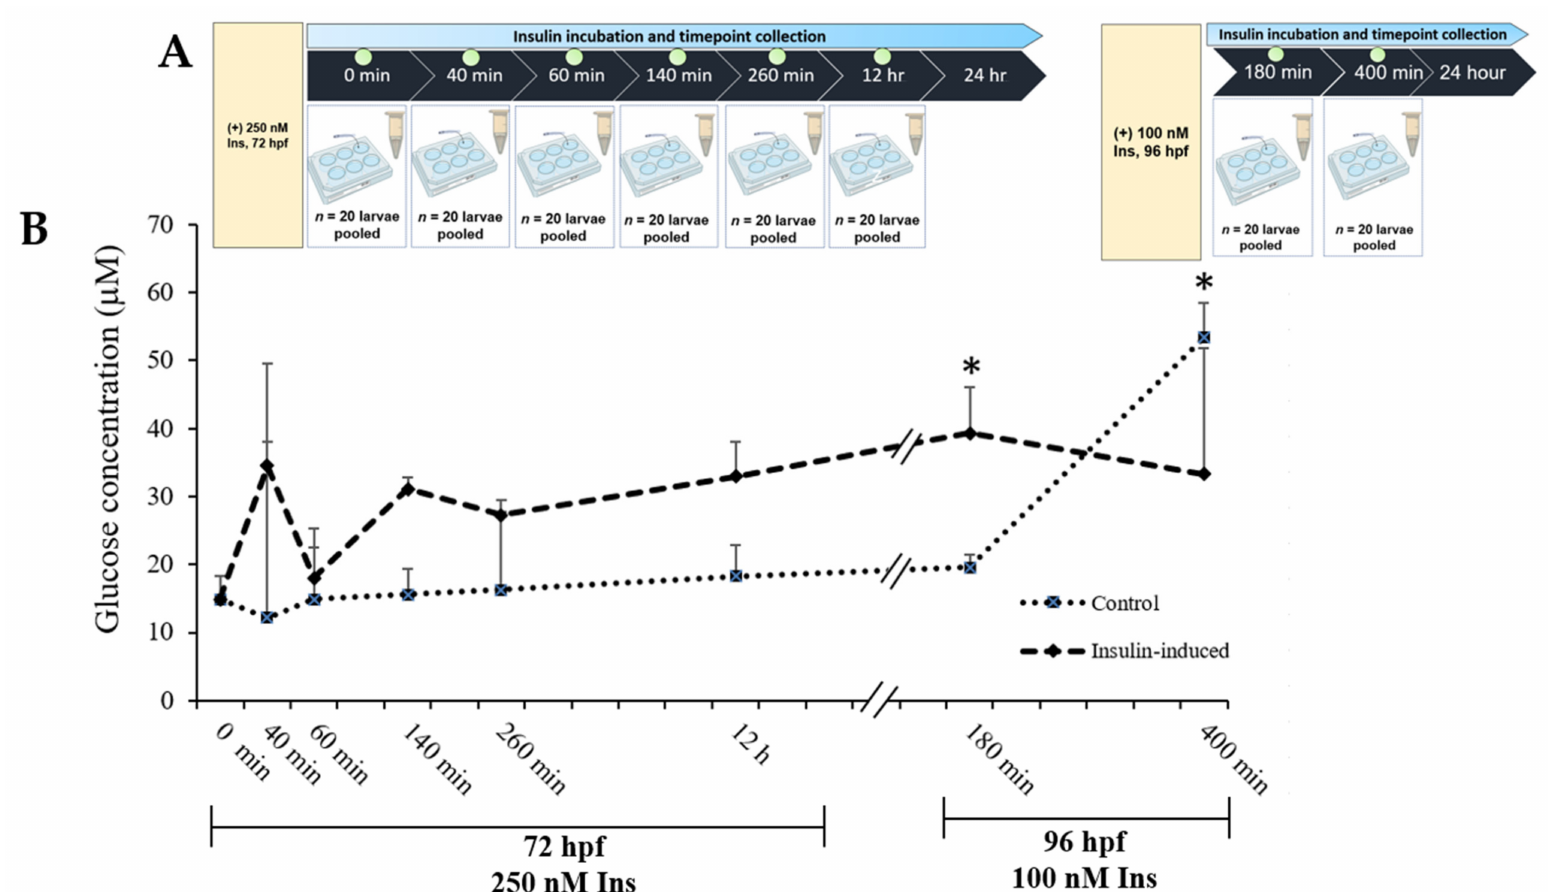
Figure 1. ( A ) Layout of experimental protocol of insulin inductions in zebrafish larvae. Larvae were induced with 250 nM insulin at 72 hpf followed by sampling after completion of the first insulin induction at 0, 40, 60, 260 and 12 h. The second induction with 100 nM insulin at 96 hpf followed by sampling after the second insulin induction was completed at 180 and 400 min. The control group was immersed in E3 medium. ( B ) The effects of post-insulin induction on a glucose dynamic study by zebrafish larvae during the first and second insulin inductions. The x-axis values on the scale are in minutes or hours while the y-axis values on the scale are in micromolars. The data are expressed in (mean ± SEM). Statistically significant values are expressed as * p <